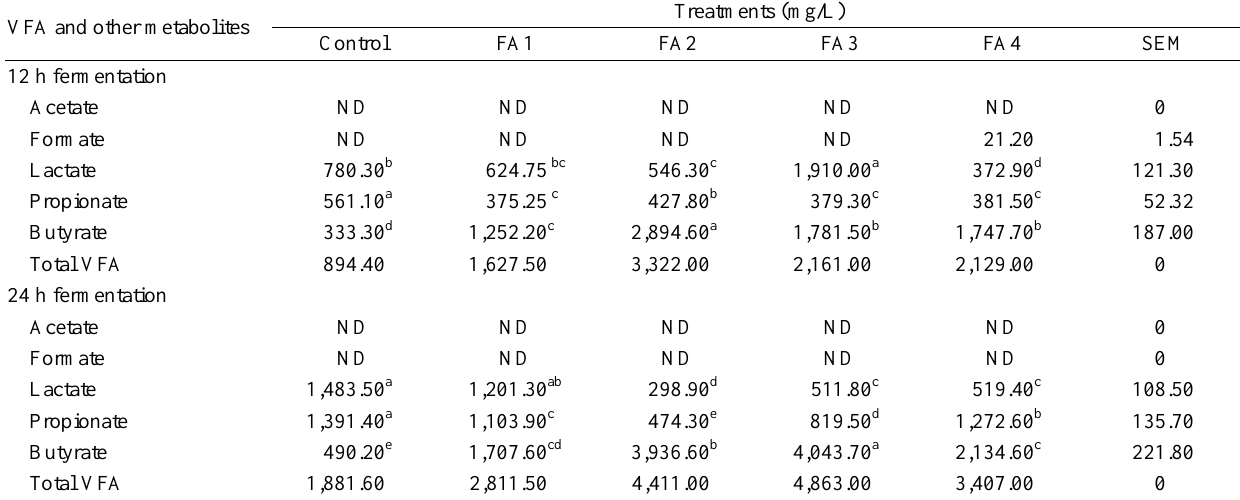
Table 3. Volatile fatty acids (VFA) and other metabolites production of in vitro fermented swine fecal slurry added with soybean meal and different phytogenic feed